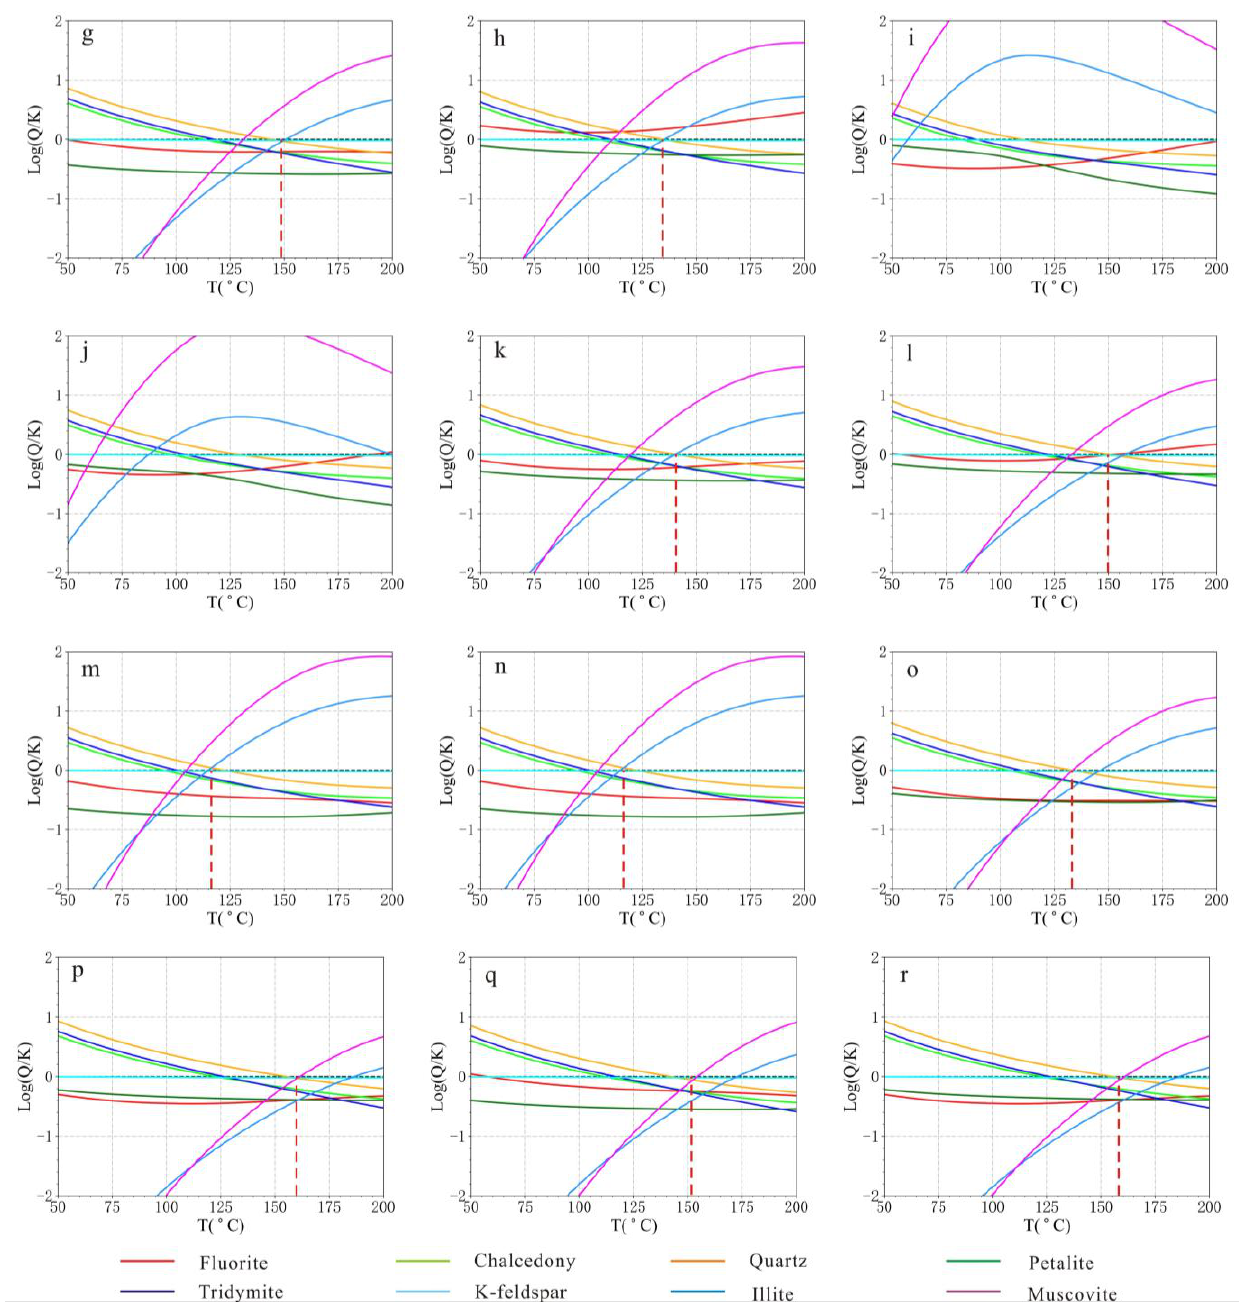
Figure 7. Mineral saturation diagram for the typical hot spring in southeastern China: ( a ) — Huangkeng; ( b ) — Tangdou; ( c ) — Xintang; ( d ) — Tangkeng; ( e ) — Xiazhuang; ( f ) — Songling; ( g ) — Jingu; ( h ) — Tangtou; ( i ) — Pangu; ( j ) — Xuemei; ( k ) — Tianli; ( l ) — Tangan; ( m ) — Baofen; ( n ) — Yuandanhu; ( o ) — Wuyuanwan; ( p ) — Xinlinwan; ( q ) — Dongshan; ( r ) — Yuanshan.